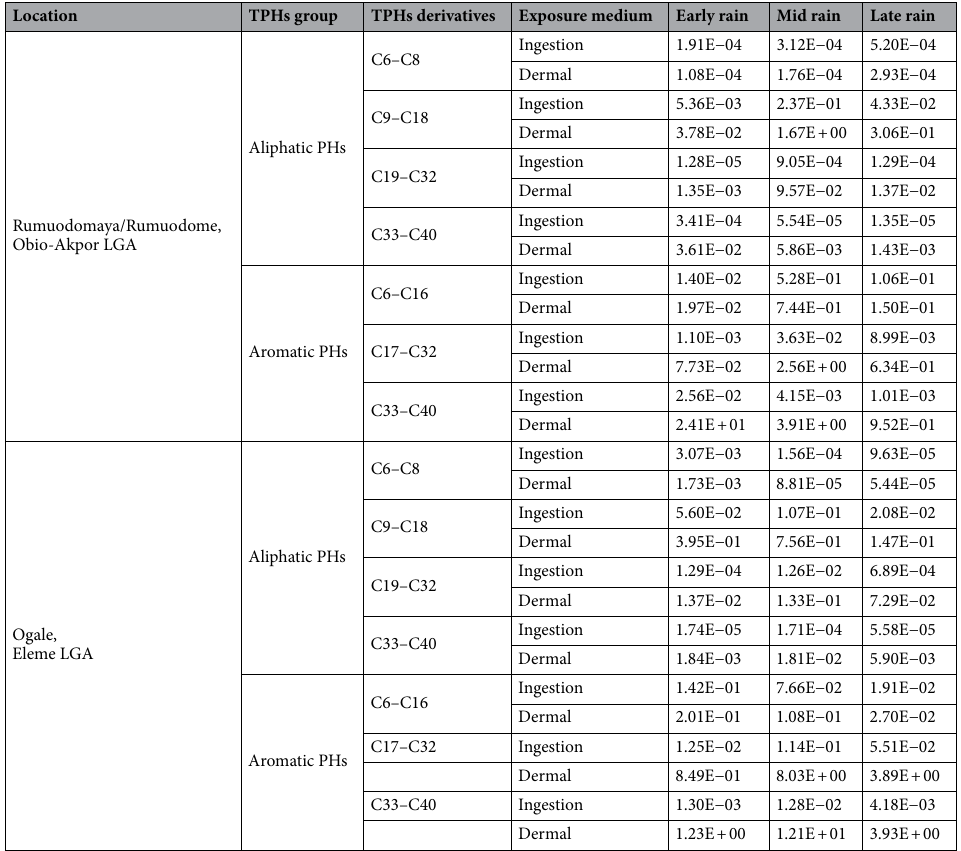
Table 12. Hazard quotient for children non-risk